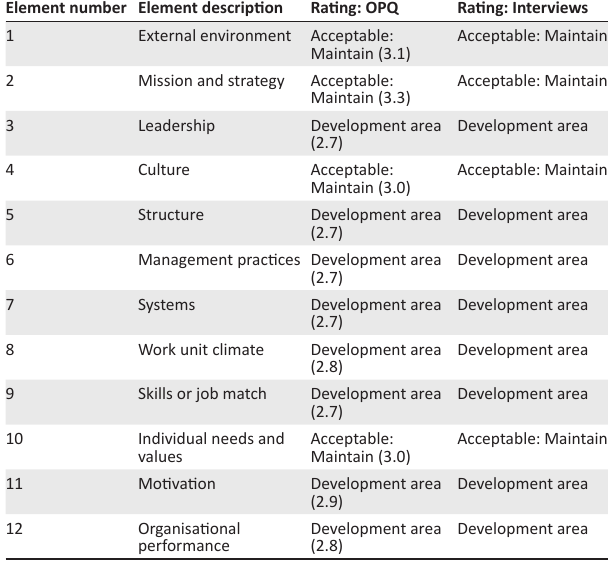
TABLE 5: Triangulation of quantitative and qualitative data. Element number Element